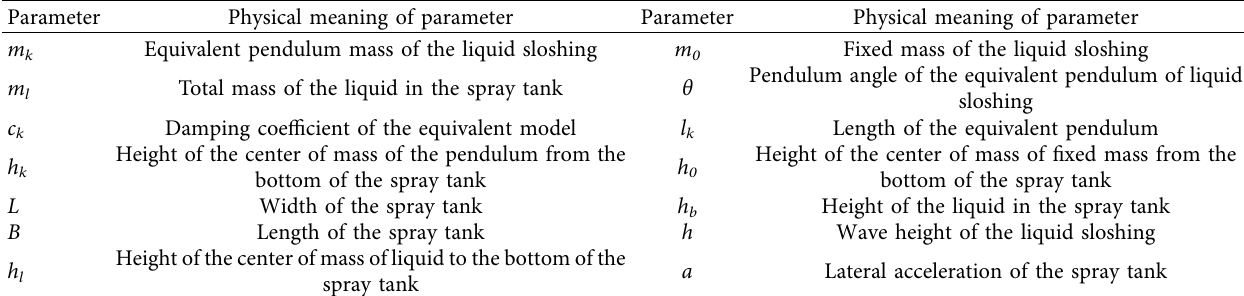
Table 4: Physical meanings of parameters in the liquid sloshing pendulum